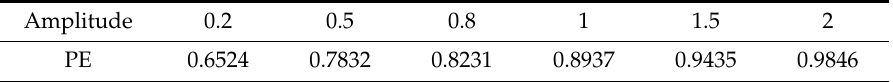
Table 1. The permutation entropy values corresponding to different noise